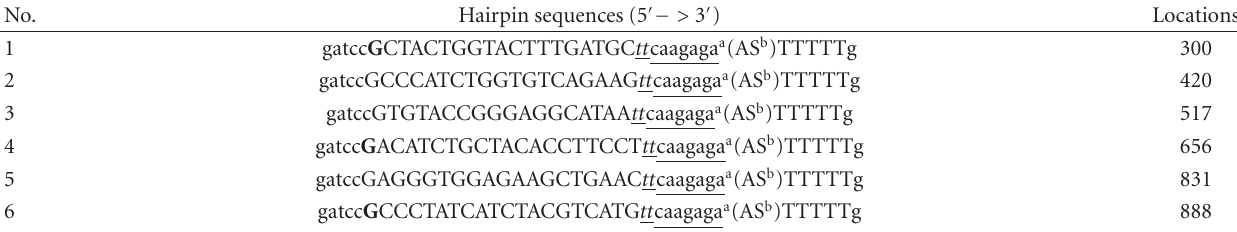
Table 2: Sequences and locations of short hairpin RNAs (note: “ G ” indicates an extra nucleotide added to the target sequence). No. Hairpin sequences (5 (cid:2) − > 3 (cid:2)